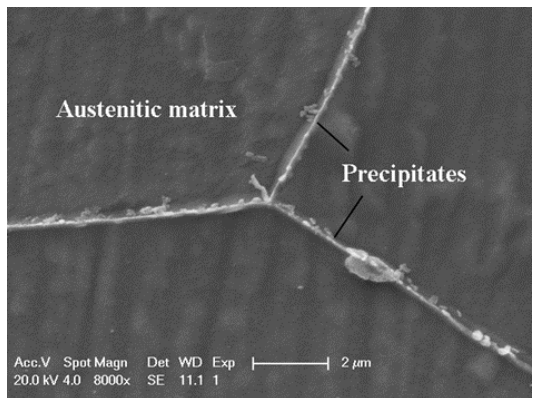
Figure 7. The SEM micrograph of the Cr–Mn–Ni–N–Cu austenitic stainless steel sample aged at 700 °C for 300 min after etching in the mixture of concentrated HCl/HNO 3 (3:1 in volume fraction) for 30 s.